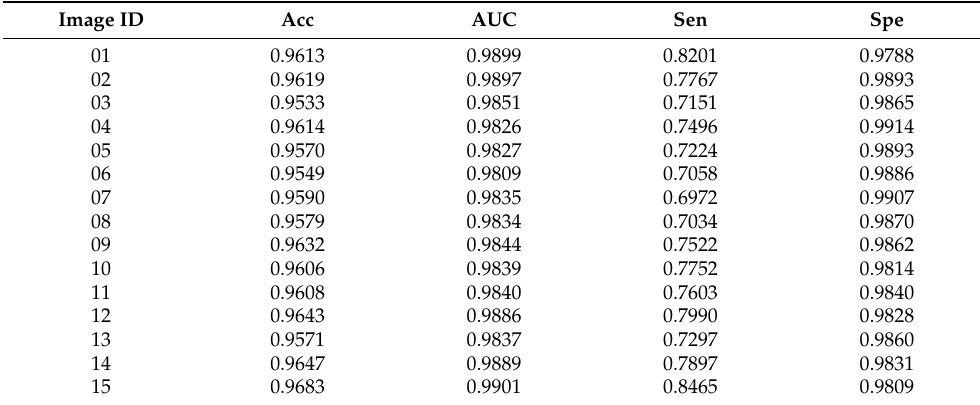
Table 5. The performance for each case of the DRIVE dataset inside